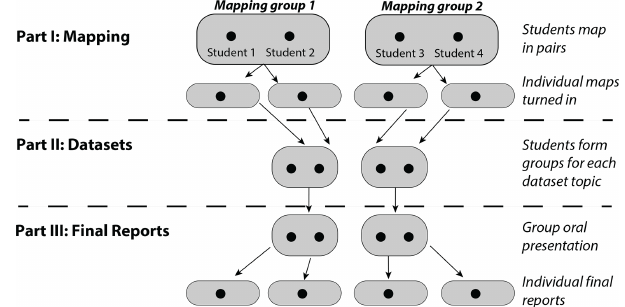
Figure 1. Schematic flowchart illustrating the multi-part structure of the module and emphasizing the combination of group and indi- vidual activities. See the text for further